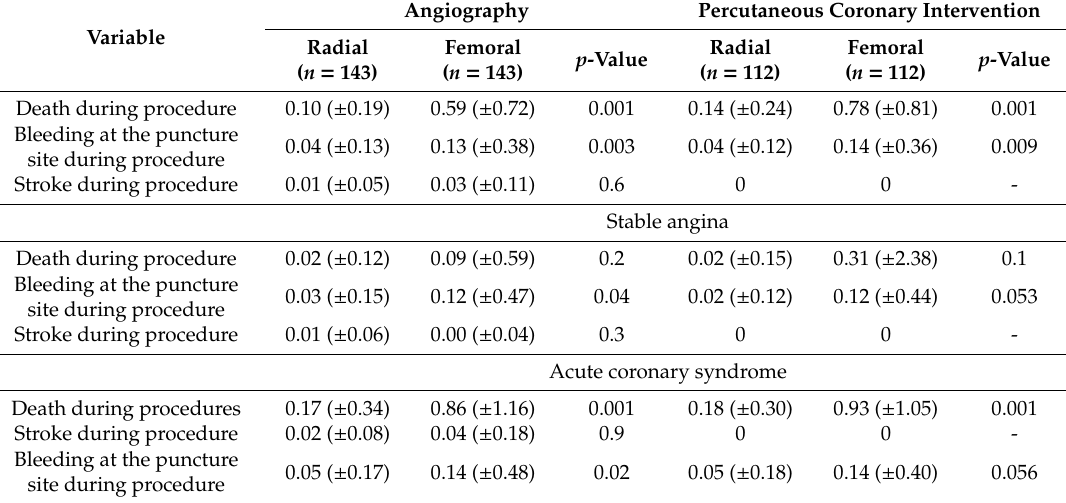
Table 9. Comparison of event rates between procedures with radial and femoral access site for stable angina and acute coronary syndrome in a group of operators performing 50–75% of procedures with radial artery.